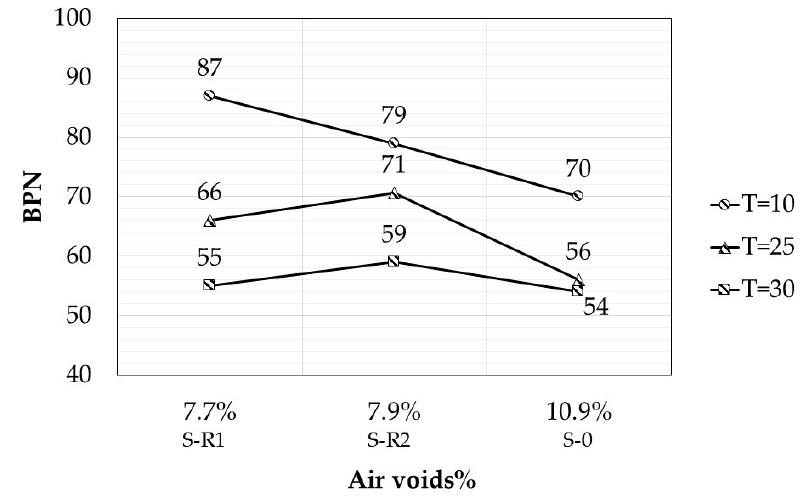
Figure 16. BPN in relation to the air void content and temperature.